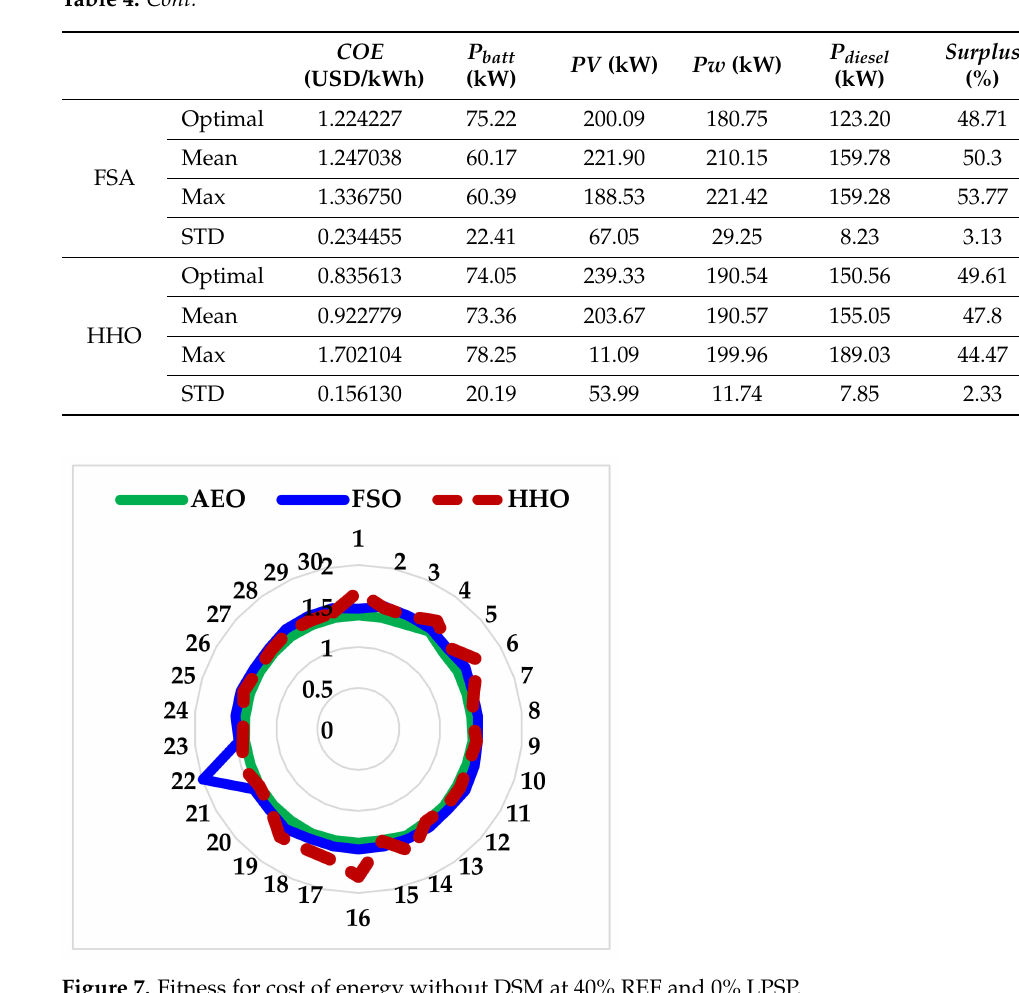
Figure 7. Fitness for cost of energy without DSM at 40% REF and 0% LPSP.